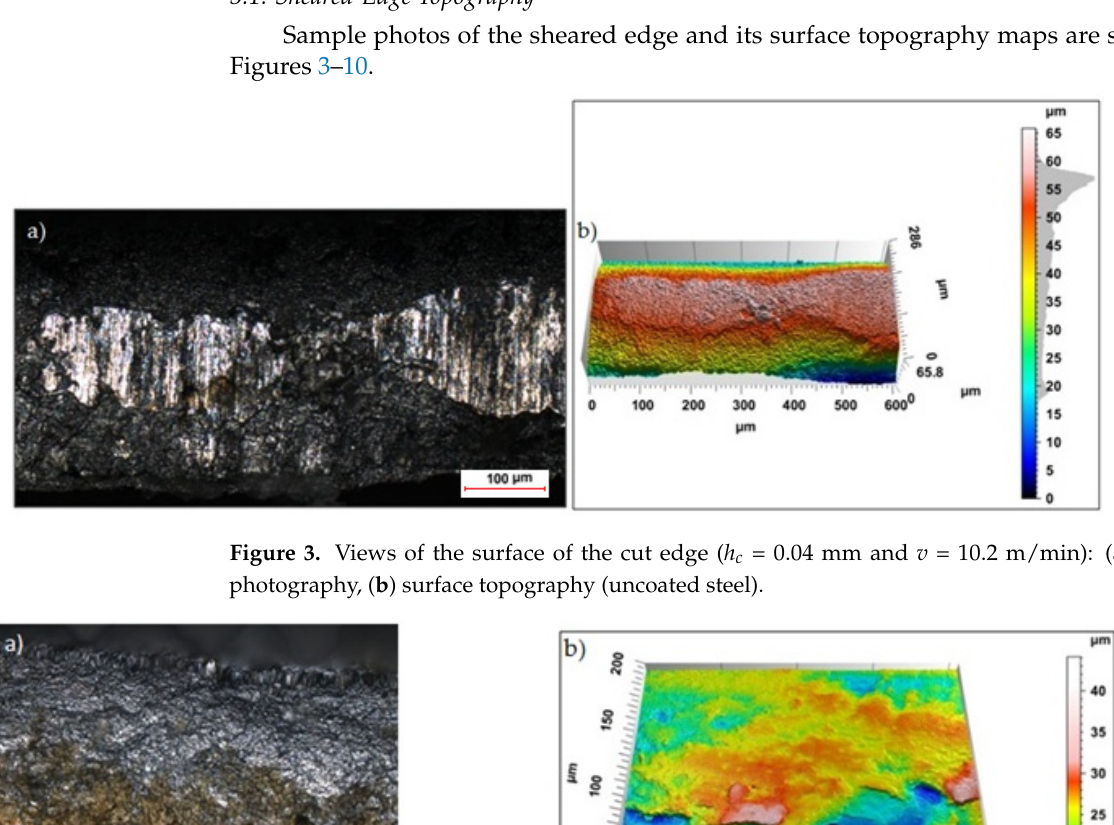
Figure 2. Typical sheared edge contour with characteristic areas, cross-sectional scheme; s r —roll-over, s p —sheared-burnished, h z —burr.